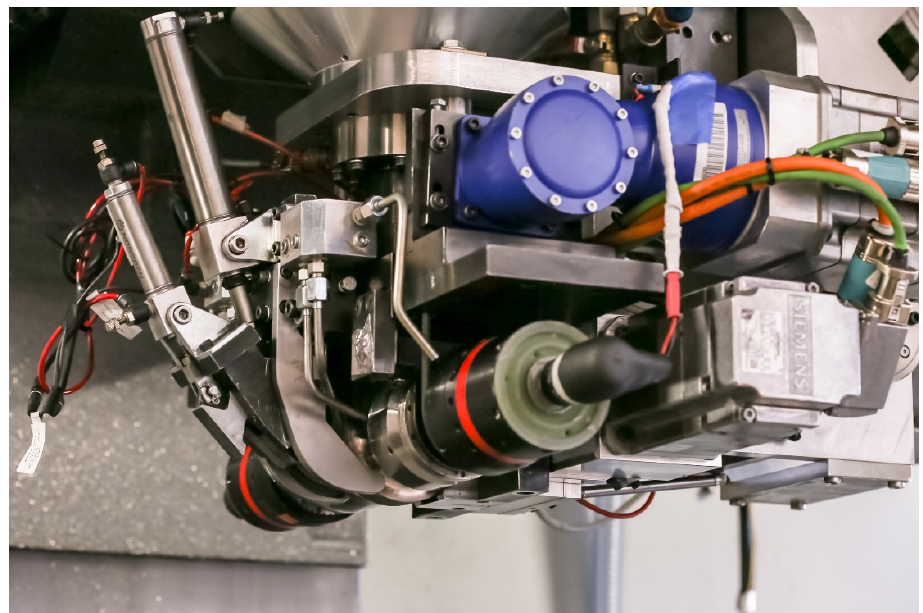
Figure 1. Welding assembly of the 9 kW ultrasonic additive manufacturing welder employed in this study